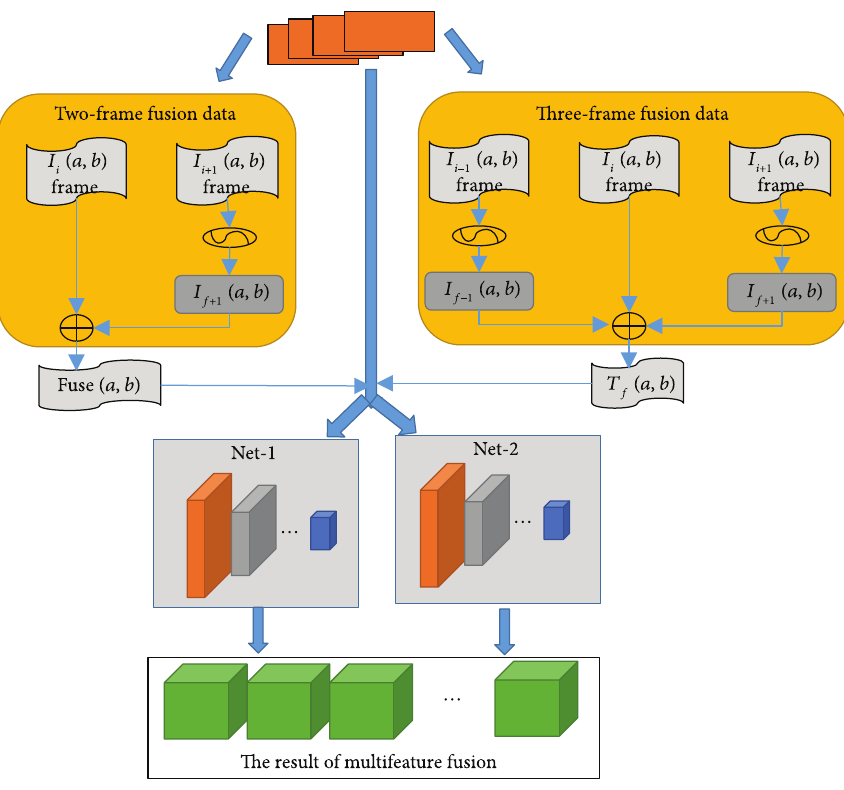
Figure 1: Multifeature fusion expression module.